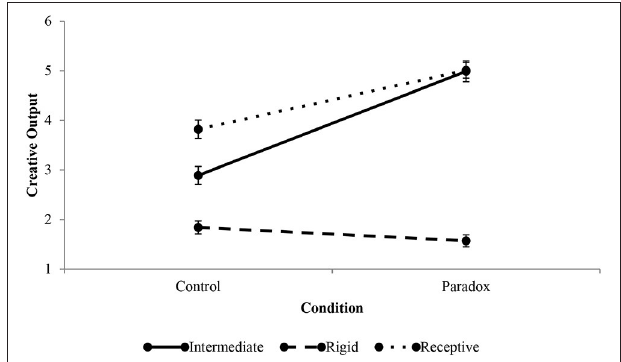
FIGURE 6 | Effect of paradox treatment on intermediate, rigid, and receptive thinking styles. Error bars indicate standard errors.